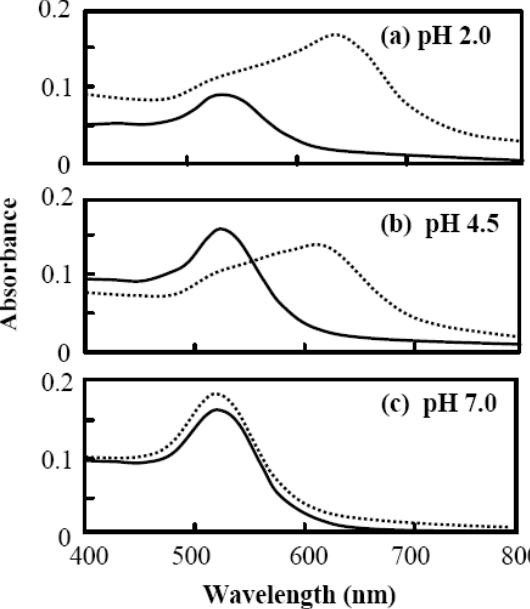
Figure 3. The absorption spectra of gold colloidal nanoparticles with a diameter of 20 nm (thick line) and A  mixed with gold colloid (dotted line) for (a) pH = 2.0, (b) pH = 4.5, 1-40 and (c) pH =